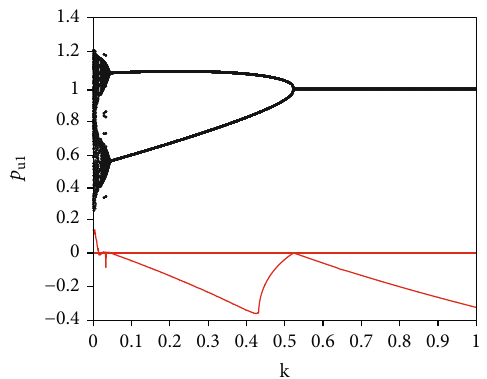
Figure 13: Bifurcation diagram with respect to k and the maximum Lyapunov exponent with respect to k when α = 0 : 2, β = 0 : 1, λ = 1 : 2, and λ = 1 : 2 2 2